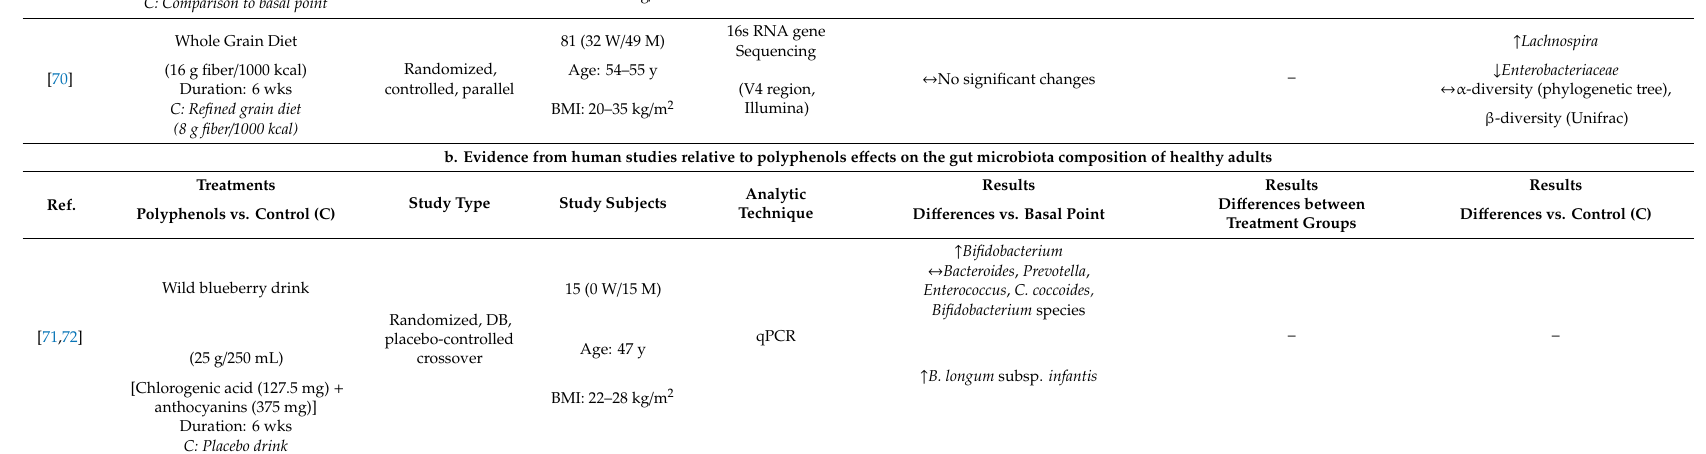
b. Evidence from human studies relative to polyphenols e ff ects on the gut microbiota composition of healthy adults